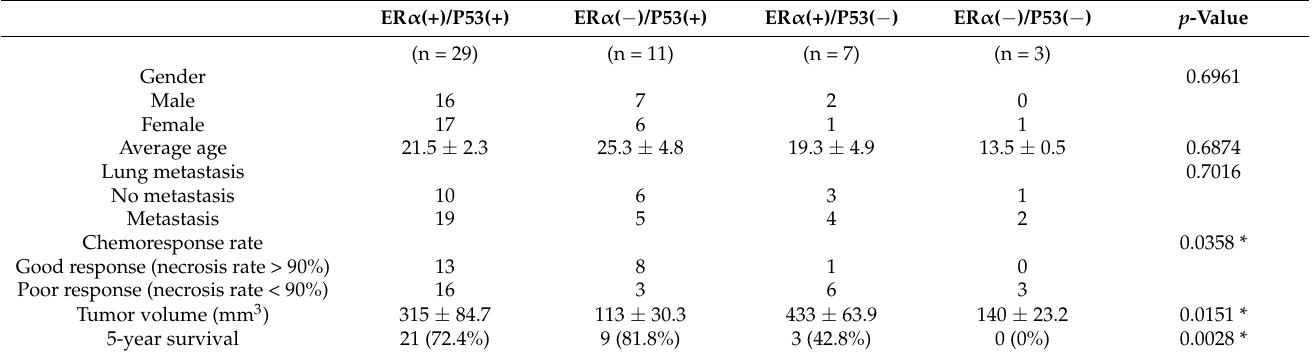
Figure 5. Combined treatment with tamoxifen enhanced the growth inhibition effects of doxorubicin on the P53(+) U2OS cell lines by suppressing CDK2 and cyclin A and inducing apoptosis. The expression levels of checkpoint factors for the S phase in the cell cycle, such as CDK2 and cyclin A, were examined by Western blot. ( A ) Treatment with doxorubicin obviously suppressed CDK2, and similar effects were achieved by the combination treatment with tamoxifen at a lower dose. ( B ) The effects of the combination treatment showed a trend of in habiting the expression of cyclin A, although there was no significant difference. ( C ) The ratio of a pro-apoptotic protein (Bax) and an anti-apoptotic protein (Bcl-2) in the combined treatment group was similar to that in the high-dose doxorubicin treatment group. ( D ) The programmed death factors, i.e., the caspases, were cleaved in the combination treatment group, indicating more efficient apoptosis. * p < 0.05 compared to the control group (C, no treatment). D2.5: doxorubicin 2.5 μ M; D5: doxorubicin 5 μ M; T5: tamoxifen 5 μ g/mL; T10: tamoxifen 10 μ g/mL; and D2.5+T5: doxorubicin 2.5 μ M + tamoxifen 5 μ g/mL. Table 1. Clinical outcome of osteosarcoma comparing the ER α and P53